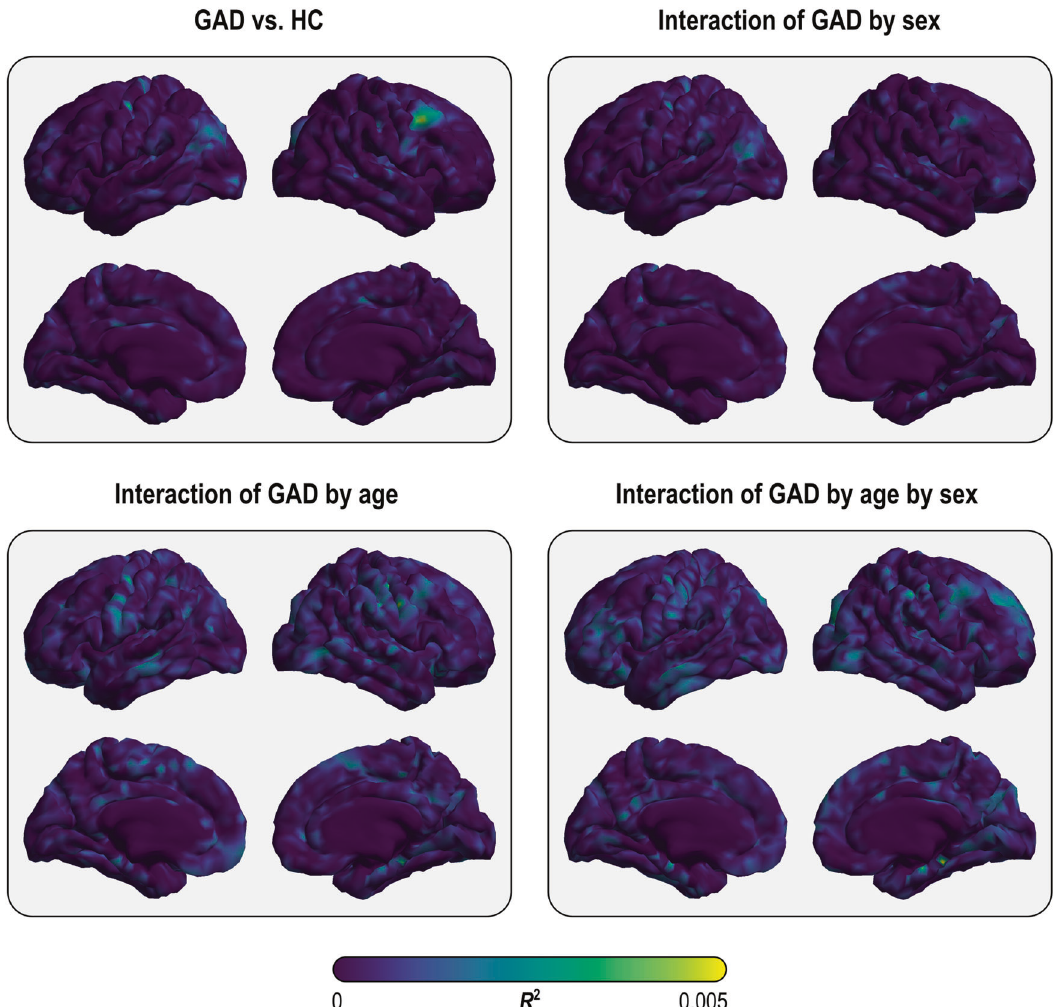
Fig. 2 Effect sizes from the main analysis for vertex-wise cortical surface area with the design that included global brain measures as nuisance variables. None of these was statistically signi fi individuals with GAD and 3282 healthy controls. Exploratory analyses including the volume of gray matter within subcortical structures